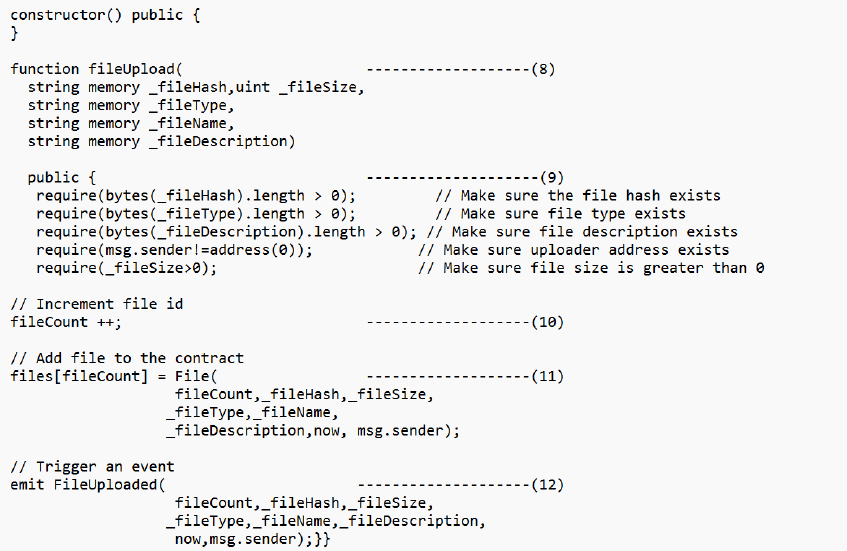
Figure 4. Solidity code for creation of a blockchain register and events to facilitate interoperability